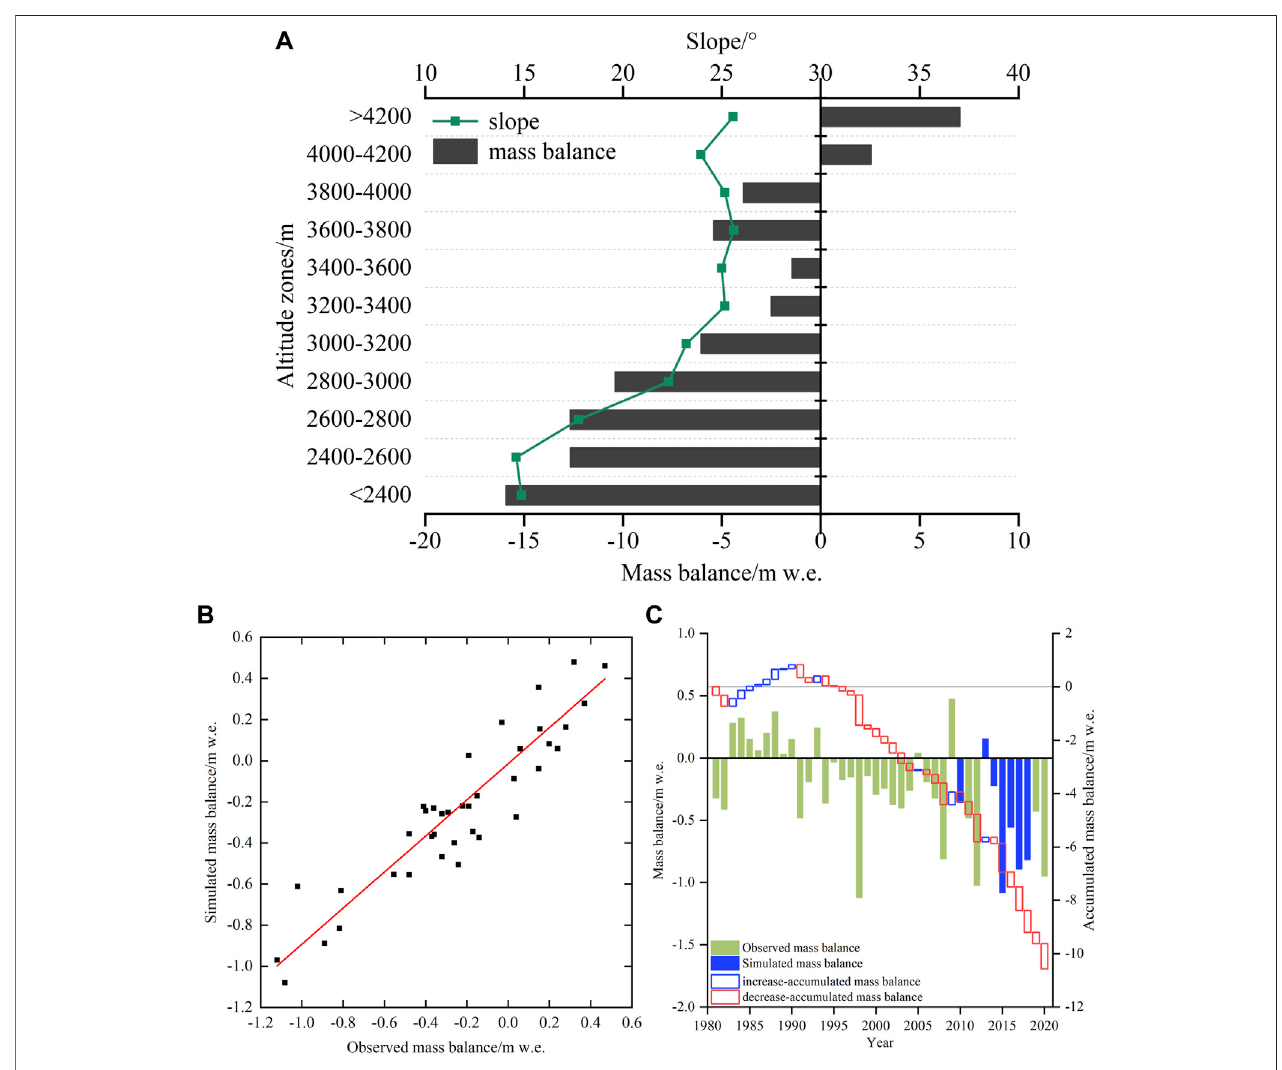
FIGURE10|(A) Glaciermassbalancefrom2000 – 2020andaverageslopewithdifferentaltitudezones. (B) Fittingofobservedmassbalancesandsimulatedmass balances for 1981 – 2012. (C) Observed mass balances and simulated mass balances of Leviy Aktru from 1981 – 2020.